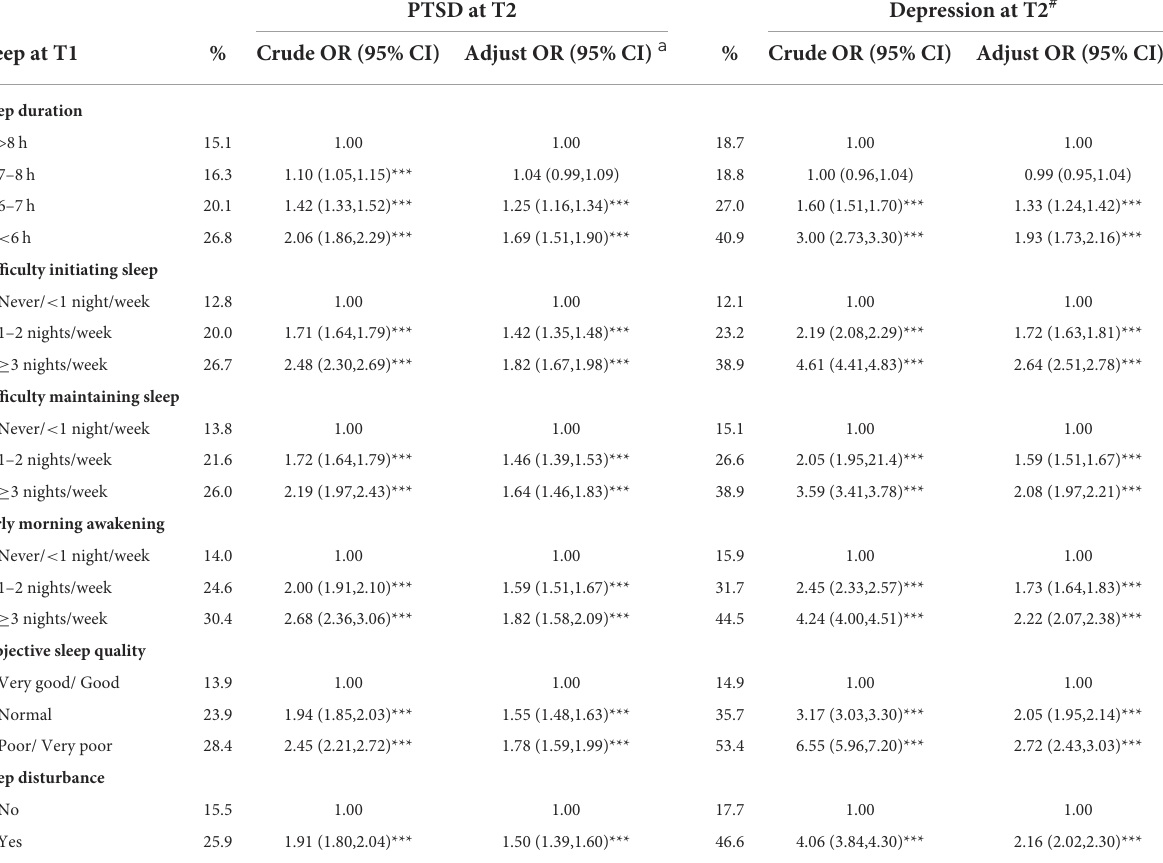
TABLE 3 Prevalence of PTSD and depression at T2 and their associations with sleep disturbance at T1. PTSD at T2 Depression at T2 # Sleep at T1 % Crude OR (95% CI) Adjust OR (95% CI) a % Crude OR (95% CI) Adjust OR (95% CI)